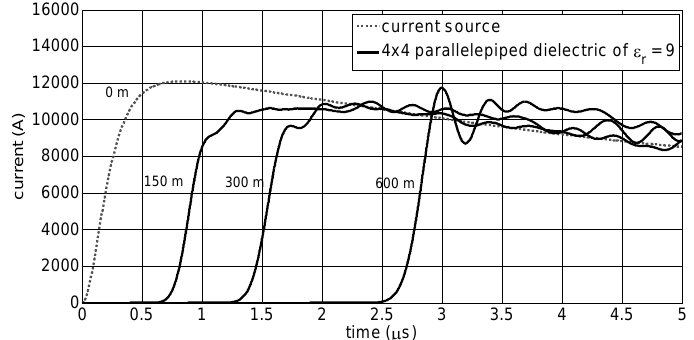
Figure 3. Current distribution along the lightning channel at different height calculated by CST-MWS for a 4 × 4 m 2 parallelepiped dielectric of ε r = 9. Model B 1: Wire embedded in a fictitious dielectric coating.